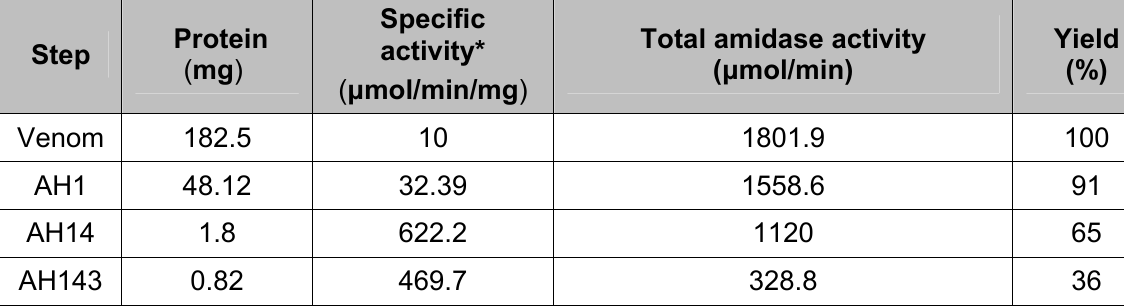
Table 1. Purification of a thrombin-like enzyme (AH143) from A. halys venom